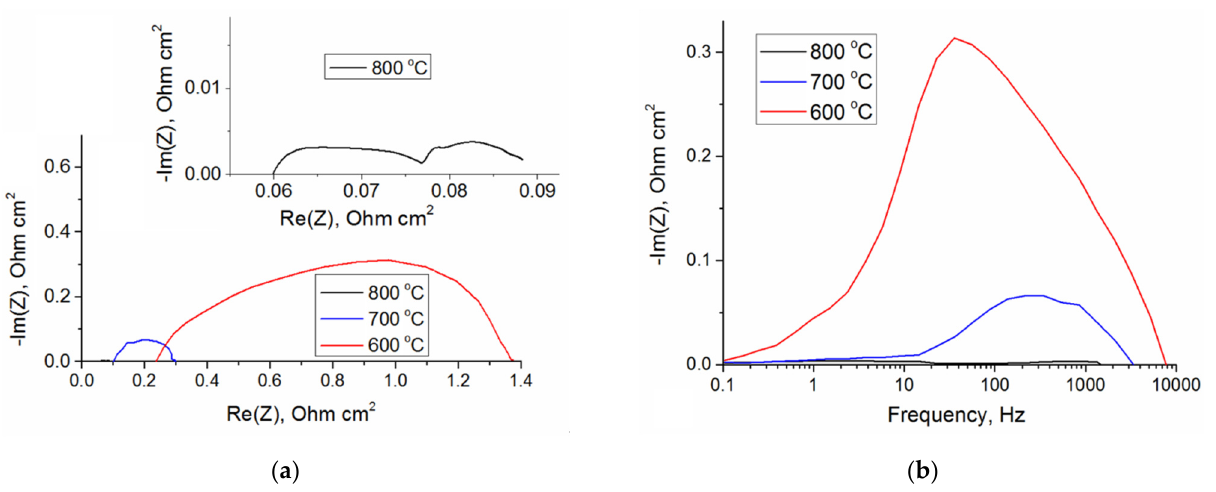
Figure 3. Impedance spectra of the SOFC with the GDC electrolyte (measured at 600–800 °C with open-circuit voltage) ( a ); Bode plots of the imaginary impedance ( b ).